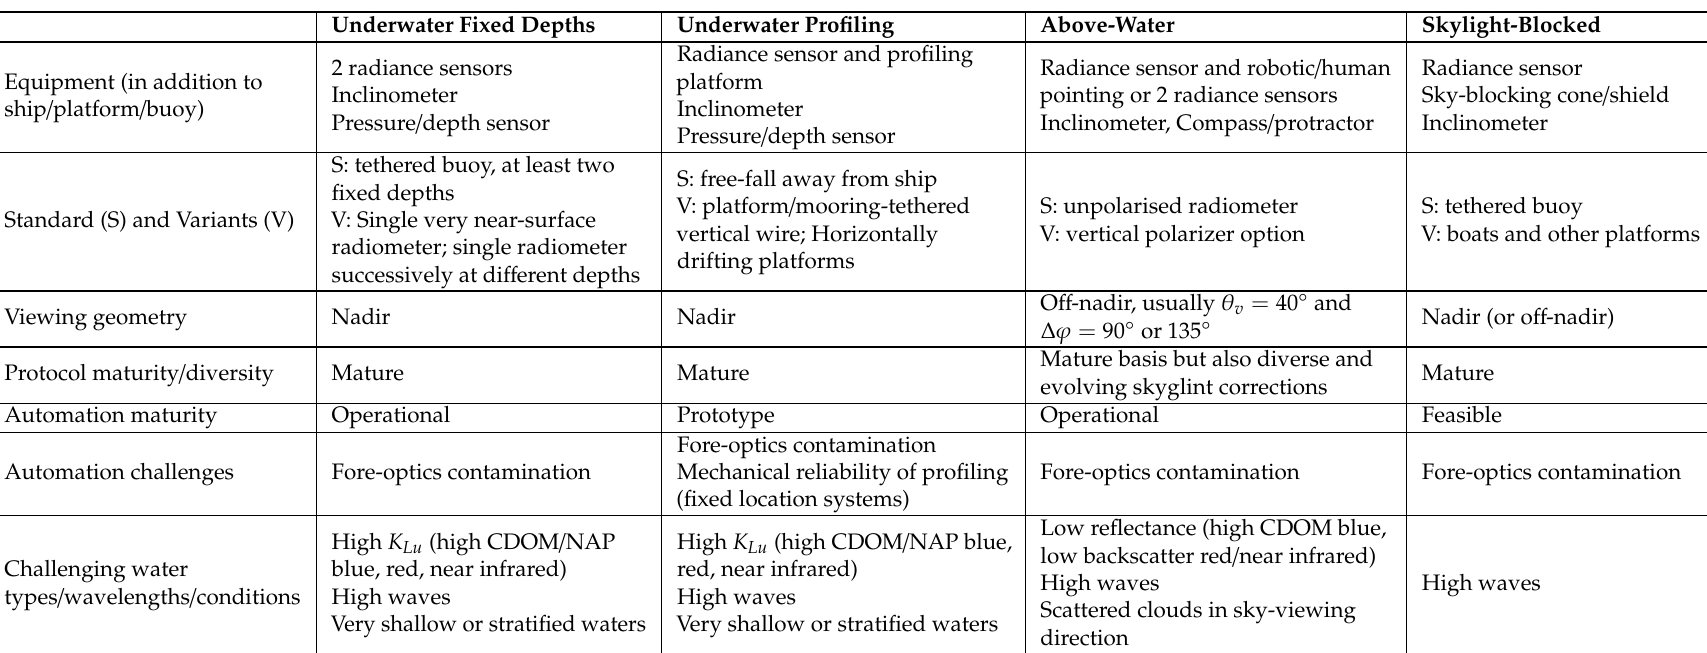
Table 1. Summary of the four measurement methods as regards: equipment; standard (S) and variant (V) methods; viewing geometry; protocol maturity / diversity; automation maturity; automation challenges; and challenging waters / wavelengths / conditions (see Section 6.2 for more details). The automation challenges refers to the protocol-specific challenges and excludes common challenges such as the logistics of maintenance visits, power supplies, hardware failures, radiometer calibration requirements, protection from damage, etc. CDOM and NAP are abbreviations for coloured dissolved organic matter and non-algae particles,